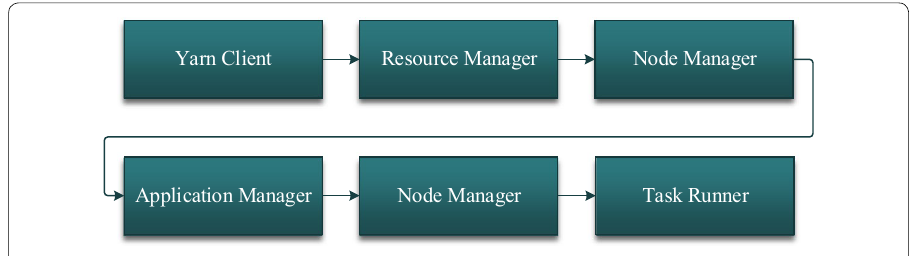
Fig. 8 High level architecture of Apache